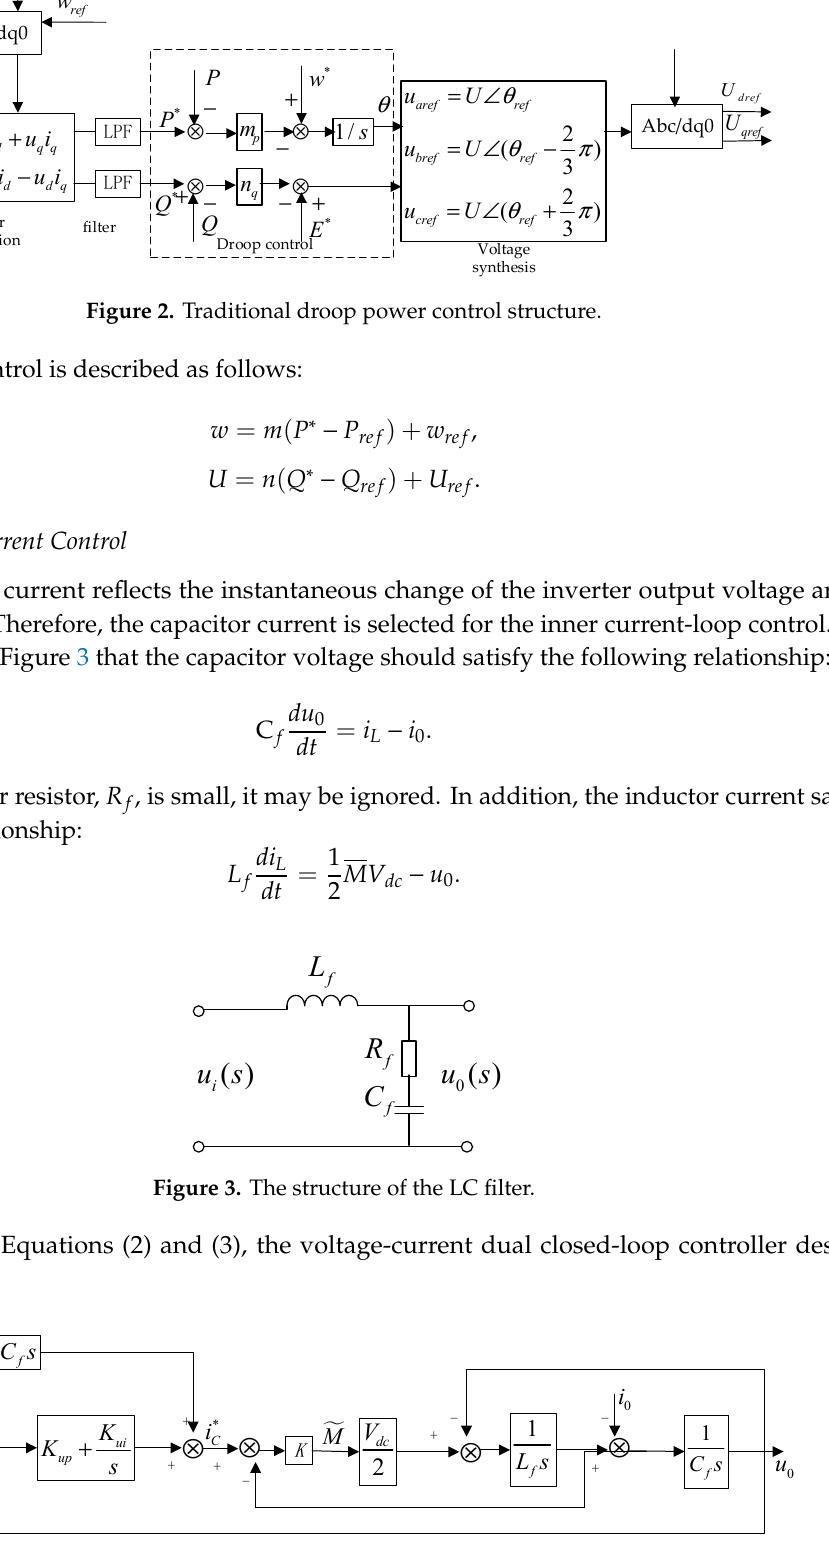
Figure 4. Dual closed-loop control of voltage and current.